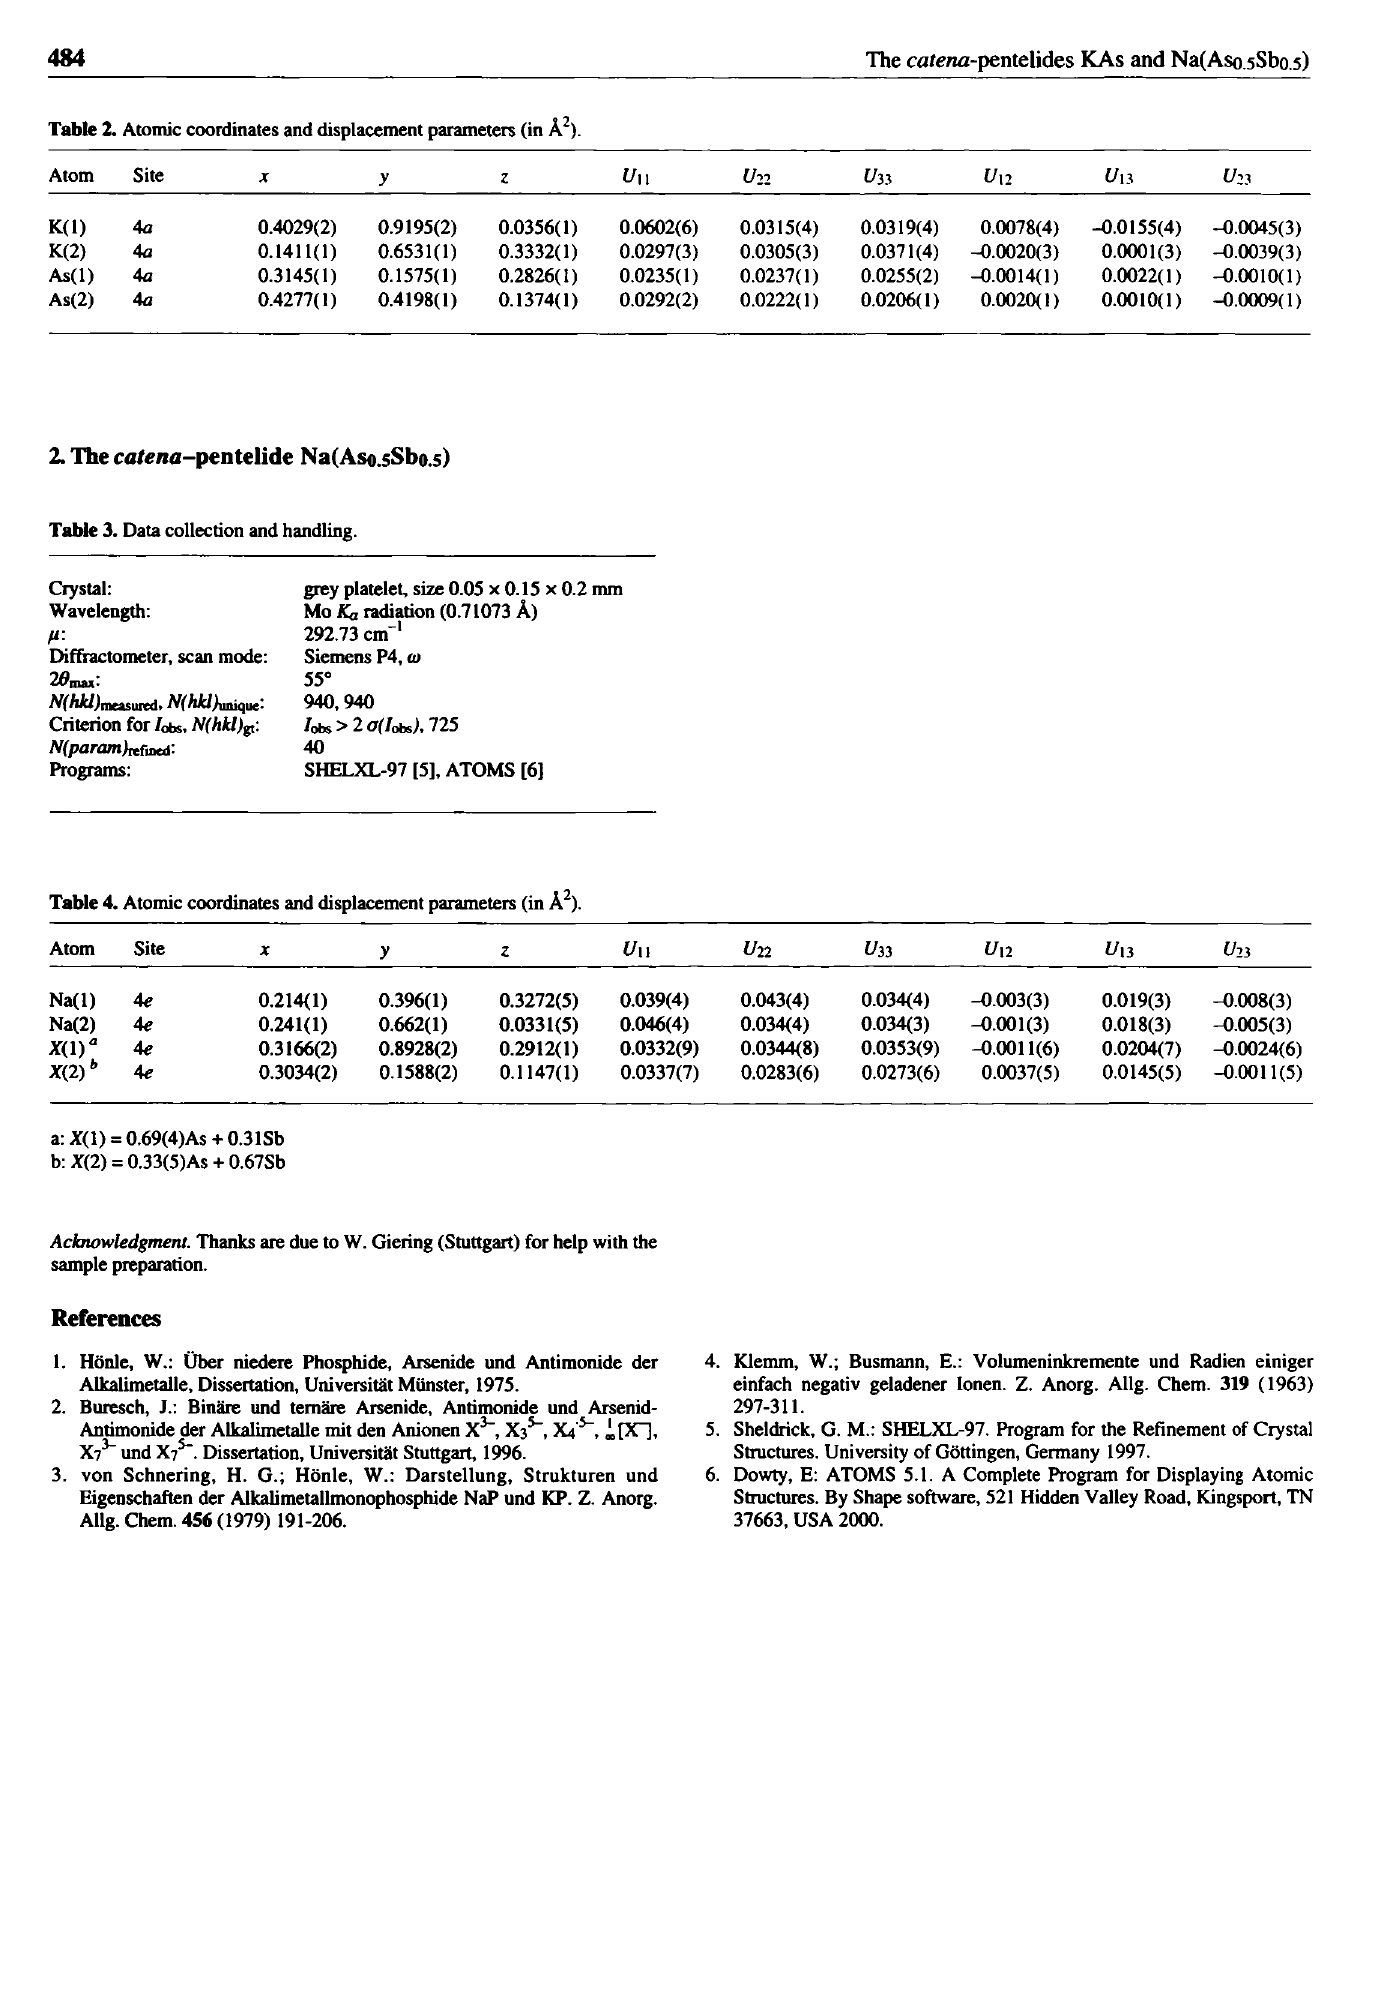
Table 2. Atomic coordinates and displacement parameters (in Â 2 ).